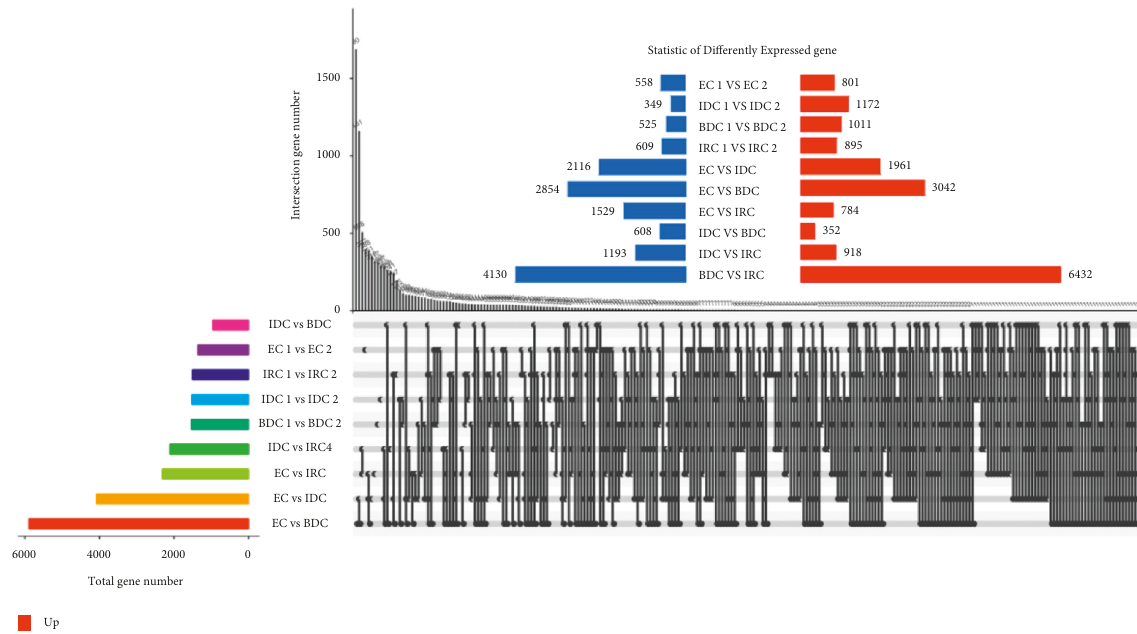
Figure 3: The statistic of DEGs counted in different